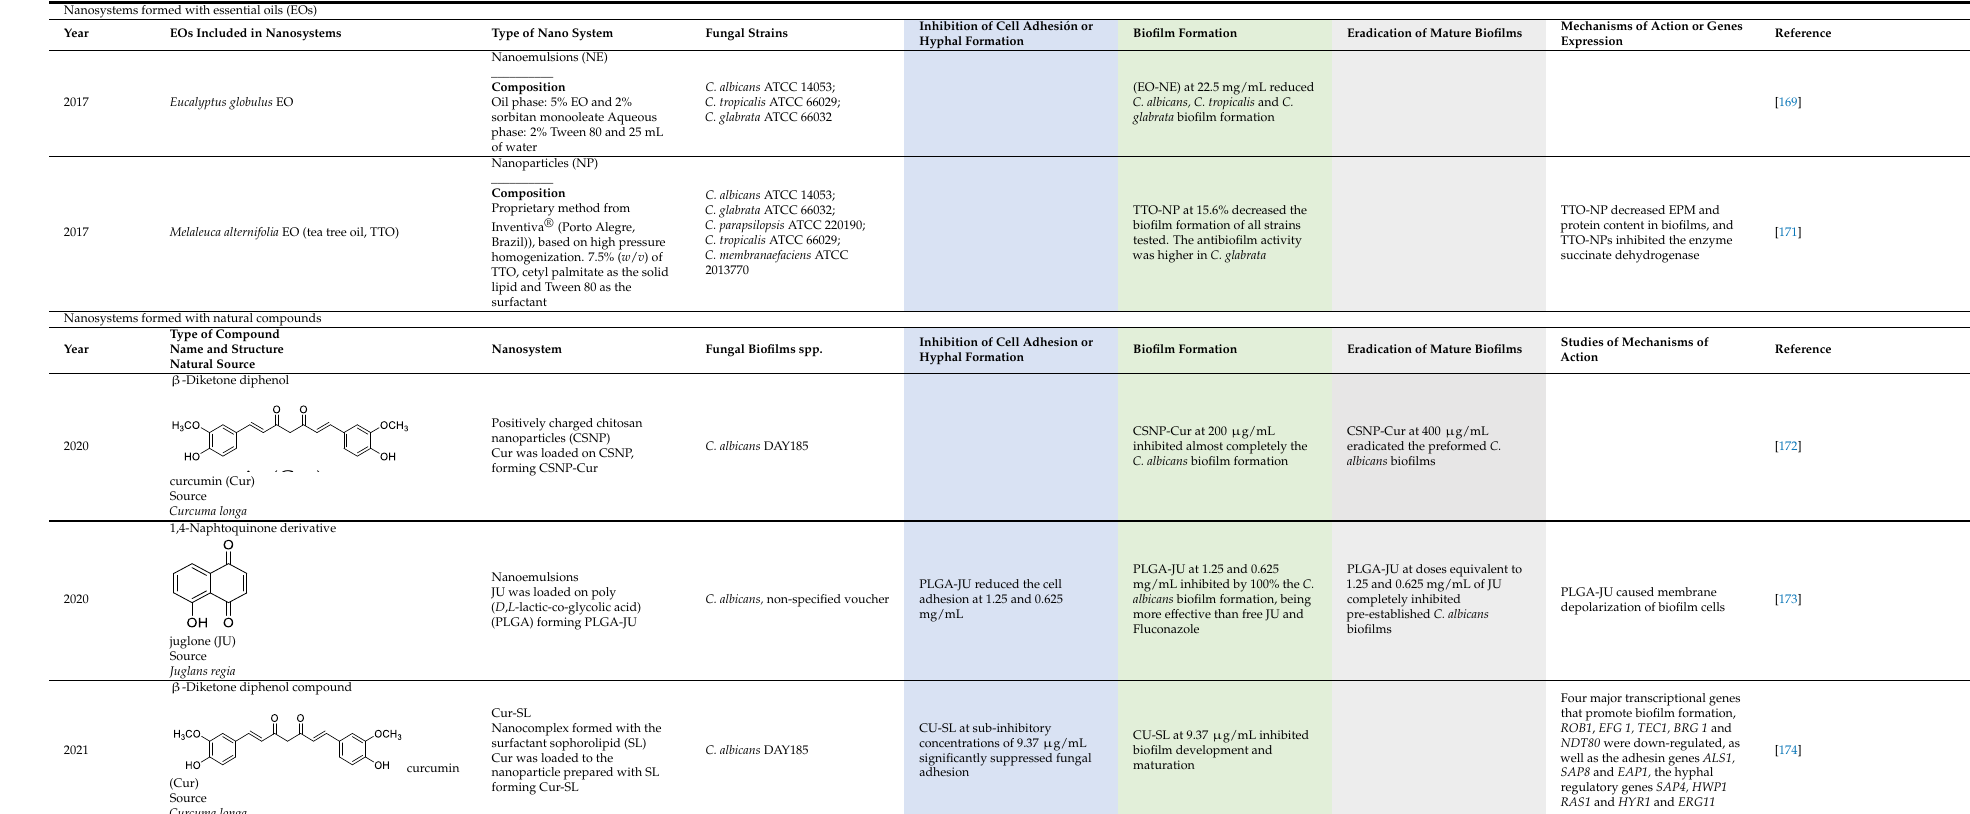
Table 5. Nanososystems containing natural products.